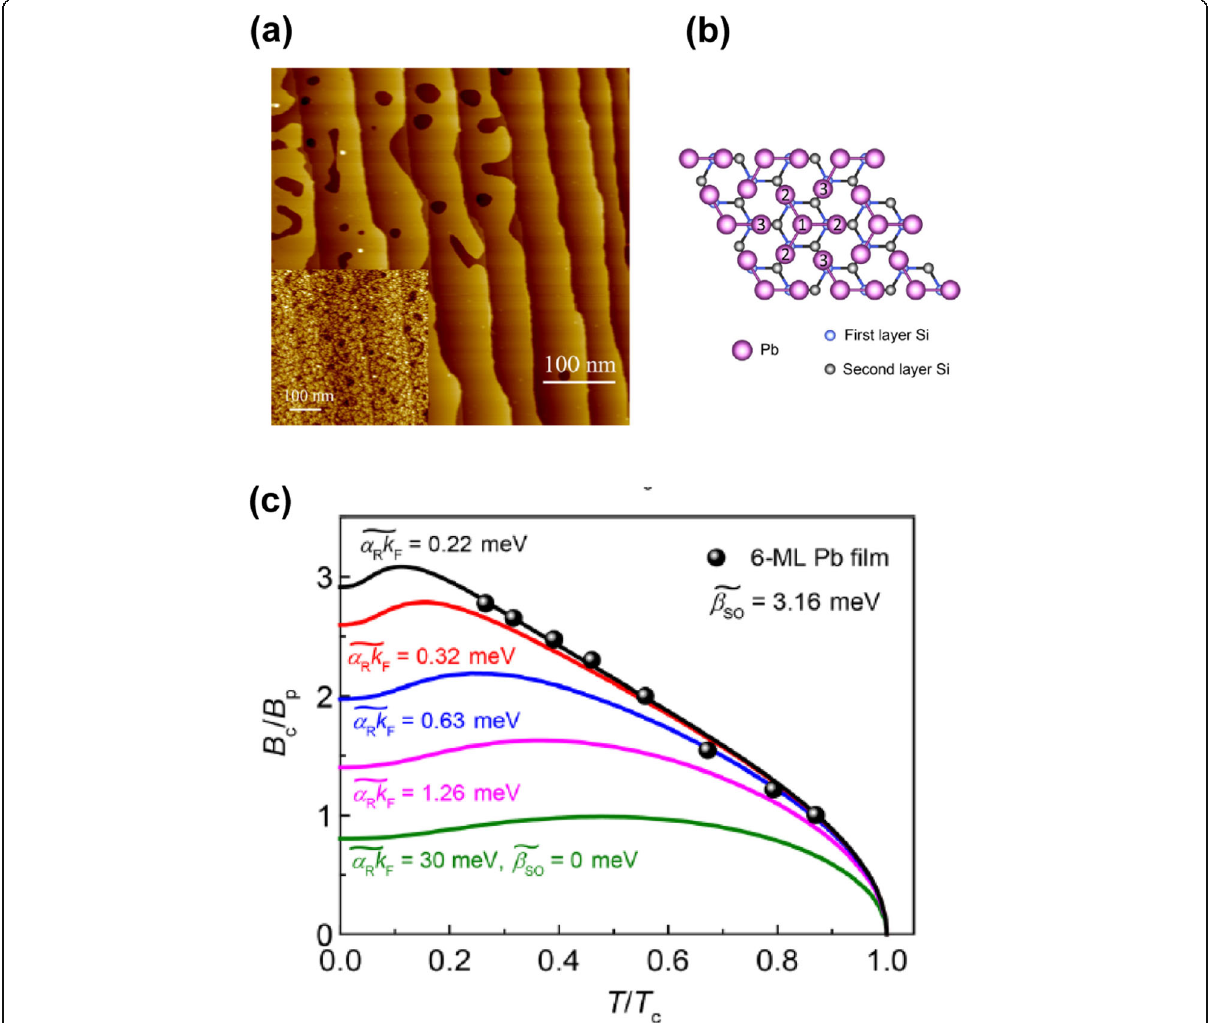
Fig. 9 In-plane critical magnetic field of Pb ultrathin films grown on Si(111)-SIC-Pb. a Typical STM image of 4 ML Pb film. b Atomic structure model of the substrate surface Si(111)-SIC-Pb. c Temperature dependence of in-plane critical field of 6-ML-thick Pb ultrathin films and fitting results based on a theoretical model. Reprinted figure with permission from Y. Liu et al. Phys. Rev. X 8 , 021002 (2018) [104]. Copyright 2018 by the American Physical Society.